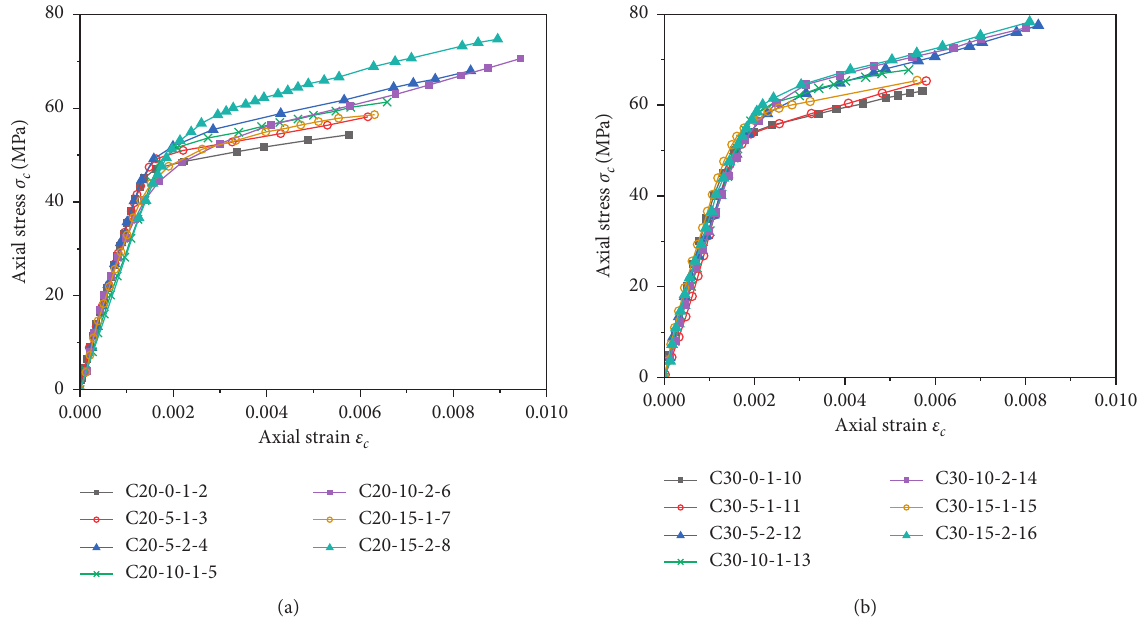
Figure 9: Test stress-strain curves. (a) Specimens of group C20. (b) Specimens of group